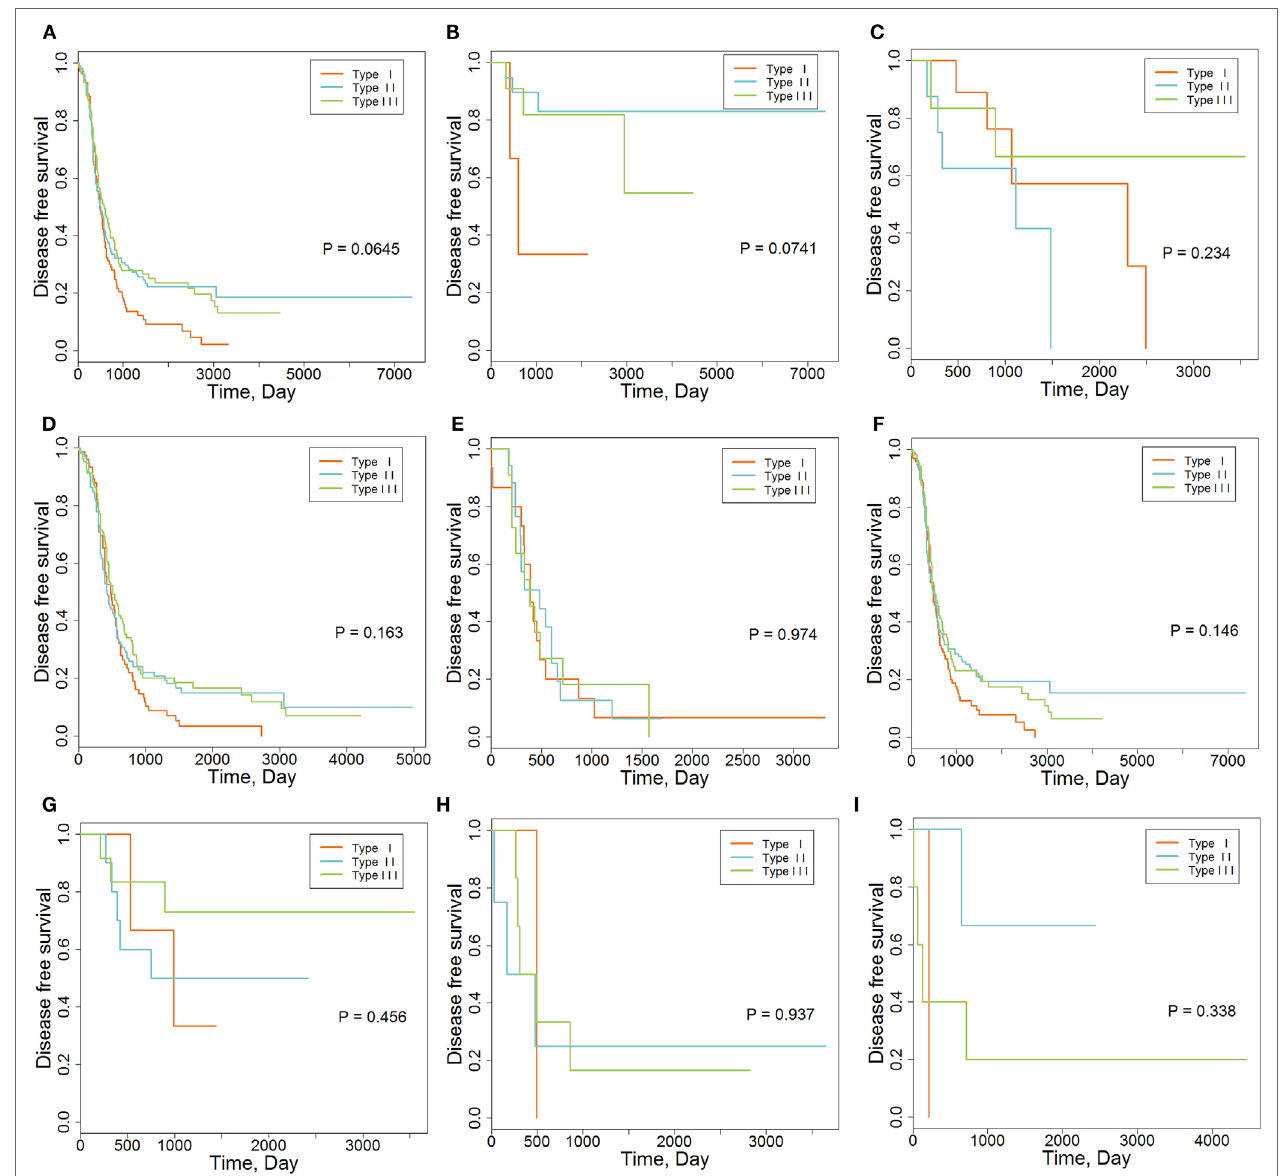
FigUre 1 | The association between immune molecular subtypes and disease-free survival. (a) Kaplan–Meier (K-M) curve for all patients ( N = 418). (b) K-M curve for stage I patients ( N = 36). (c) K-M curve for stage II patients ( N = 23). (D) K-M curve for stage III patients ( N = 315). (e) K-M curve for stage IV patients ( N = 43). (F) K-M curve for serous patients ( N = 362). (g) K-M curve for endometrioid patients ( N = 26). (h) K-M curve for clear cell patients ( N = 11). (i) K-M curve for mucinous patients ( N =